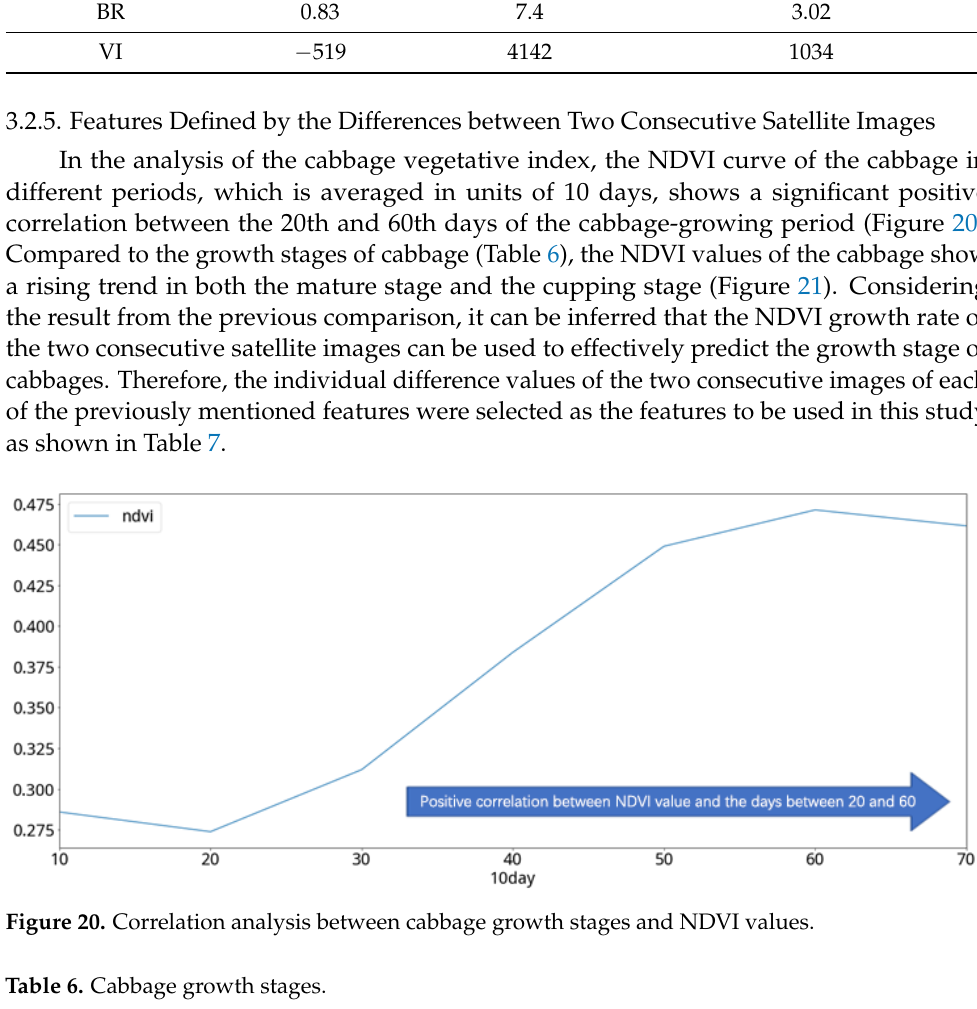
Table 5. The optimal threshold values for each feature on the basis of cross-validation method.